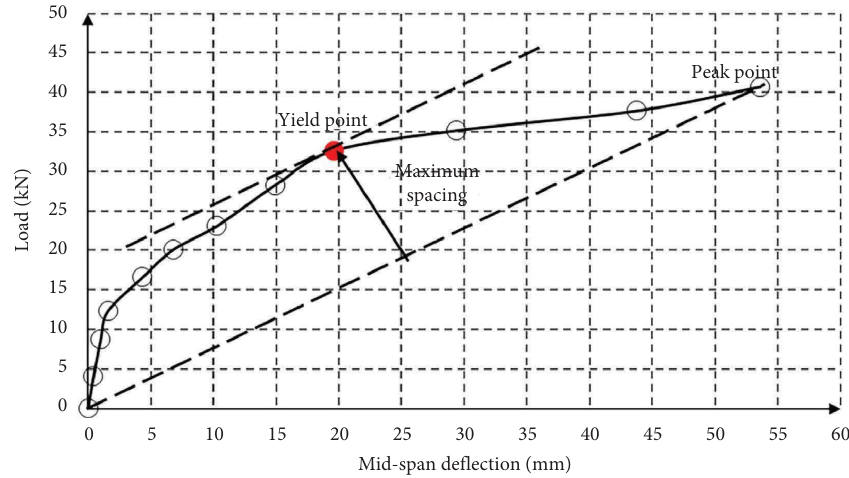
Figure 15: Farthest point method